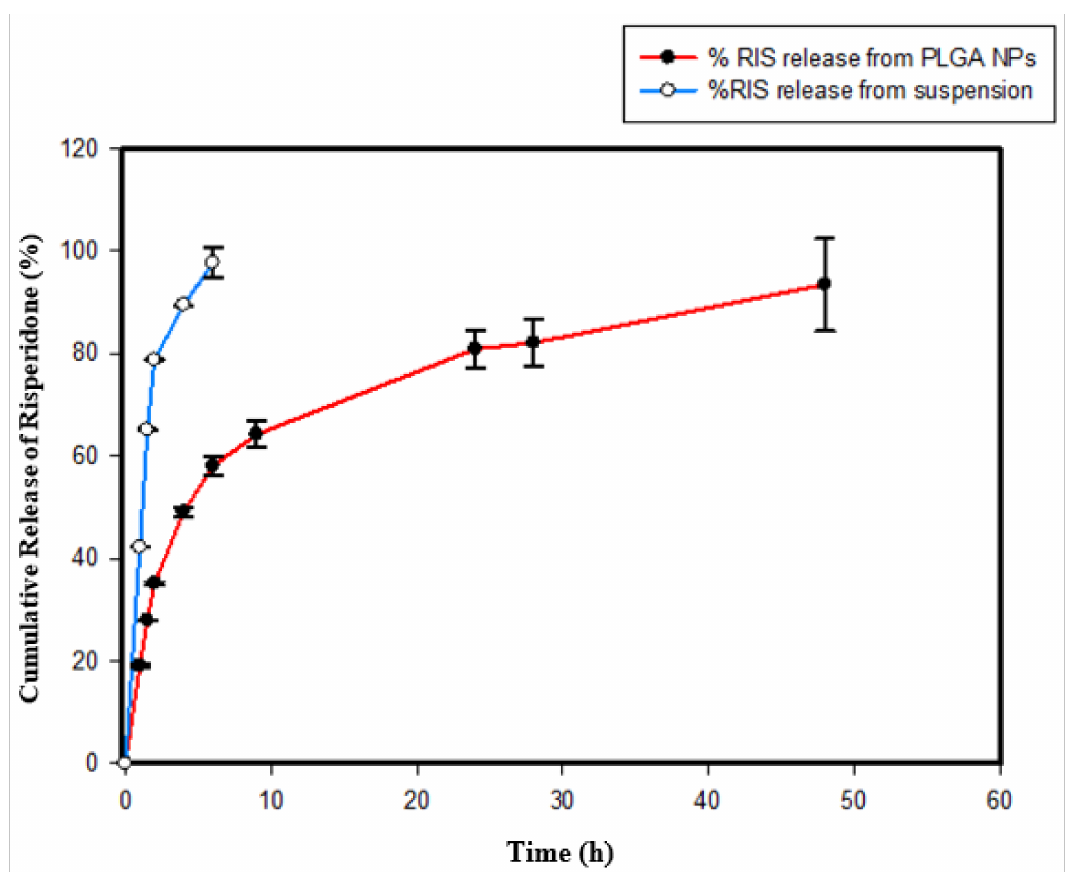
Figure 6. In vitro release profile of RIS from PLGA NPs and simple suspension in PBS (pH = 7.4, with 0.25% tween 80) at 37 ◦ C. Error bars represent standard deviation ( n =